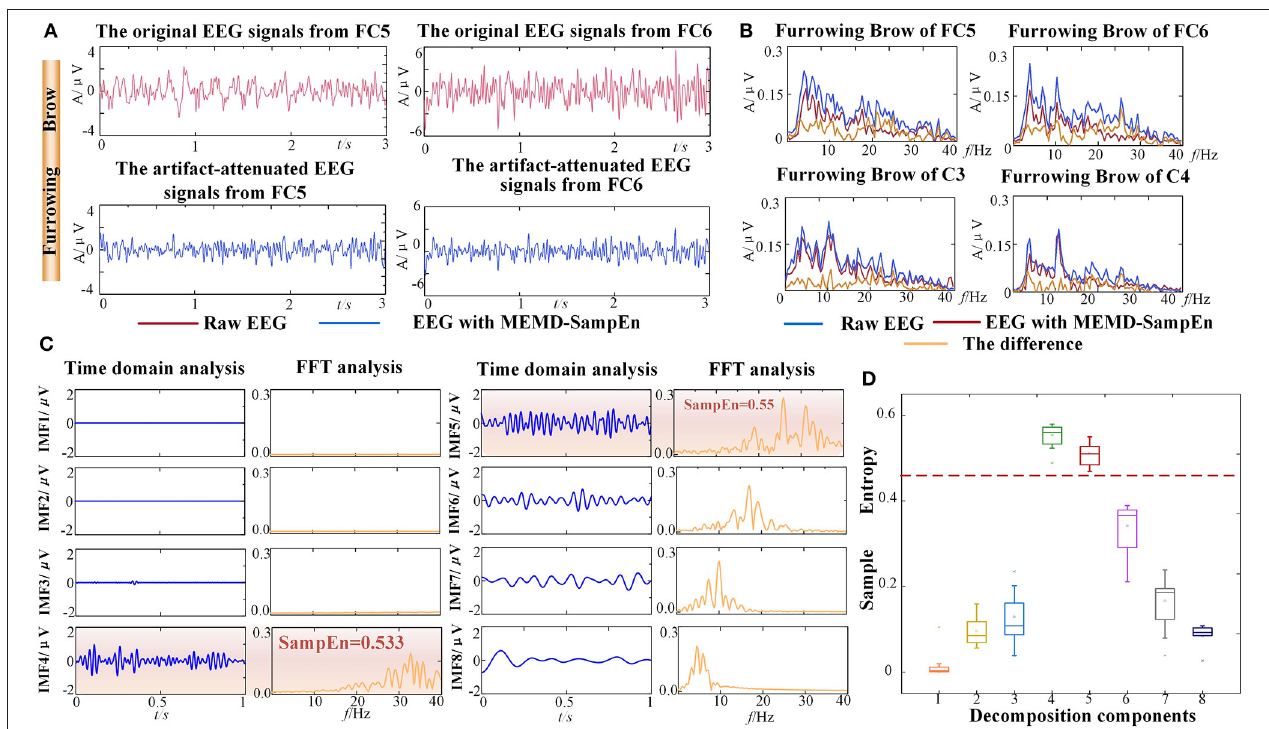
FIGURE 4 | Results of EMG artifacts removal from one representative subject (S5). (A) The time series comparison associated with the grand average Furrowing Brow expression in FC5 and FC6. (B) The FFT comparison associated with the grand average Furrowing Brow expression in FC5, FC6, C3, and C4. The curves represented the original EEG signals, the artifact-attenuated EEG signals and the differences. (C) Time domain and frequency domain analyses of the decomposition components from the NA-MEMD with the average Furrowing Brow expression in FC5. The EMG artifacts are highlighted by an orange rectangle. (D) Statistical results of the average SampEn values from first eight IMF components. Dotted line is the threshold of